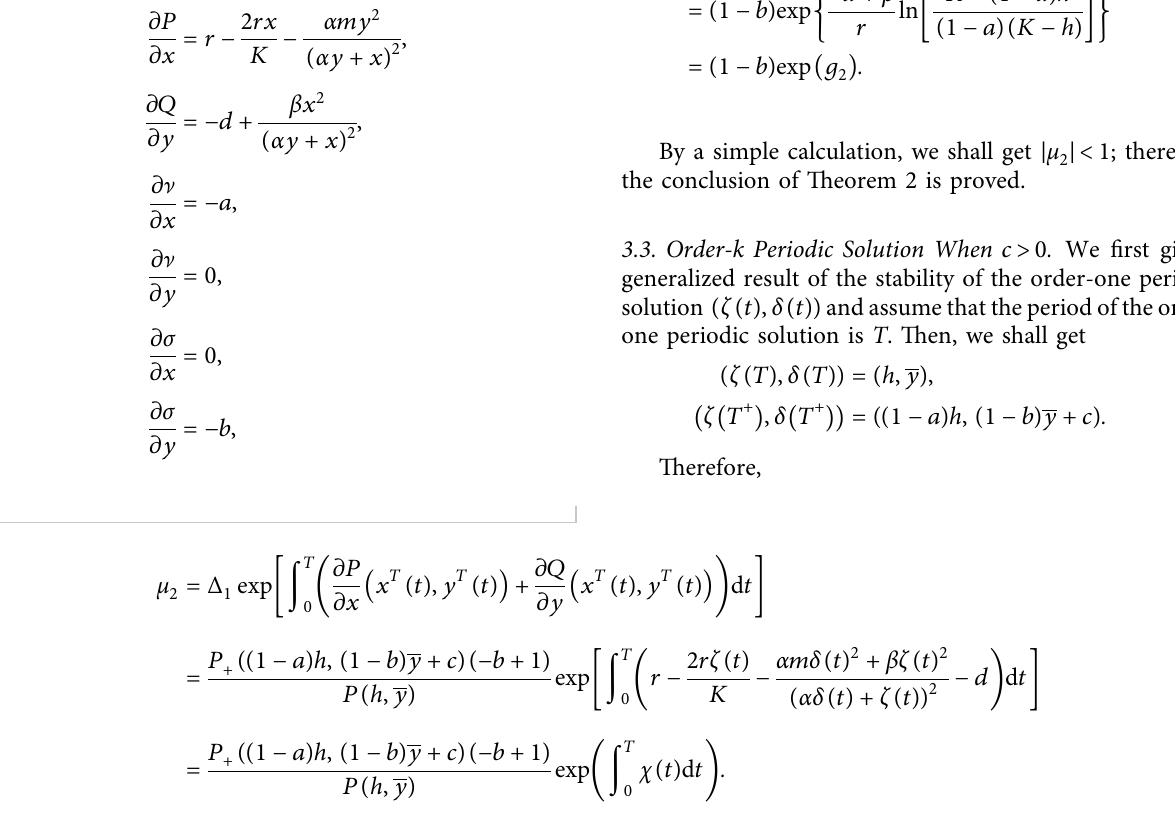
Figure 3: The relationship between Φ and y + 1 , m � 0 . 8 , α � 0 . 2 , d � 0 . 5 , β � 0 . 2 , a � 0 . 4 , b � 0 . 1 , and c � 0 .